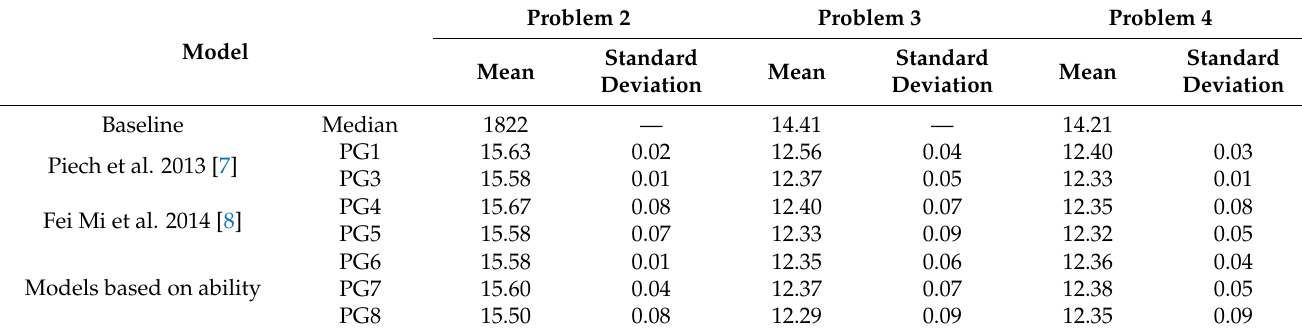
Table 3. The results of the experiment assessing the initial ability of a grader who did not offer a submission.